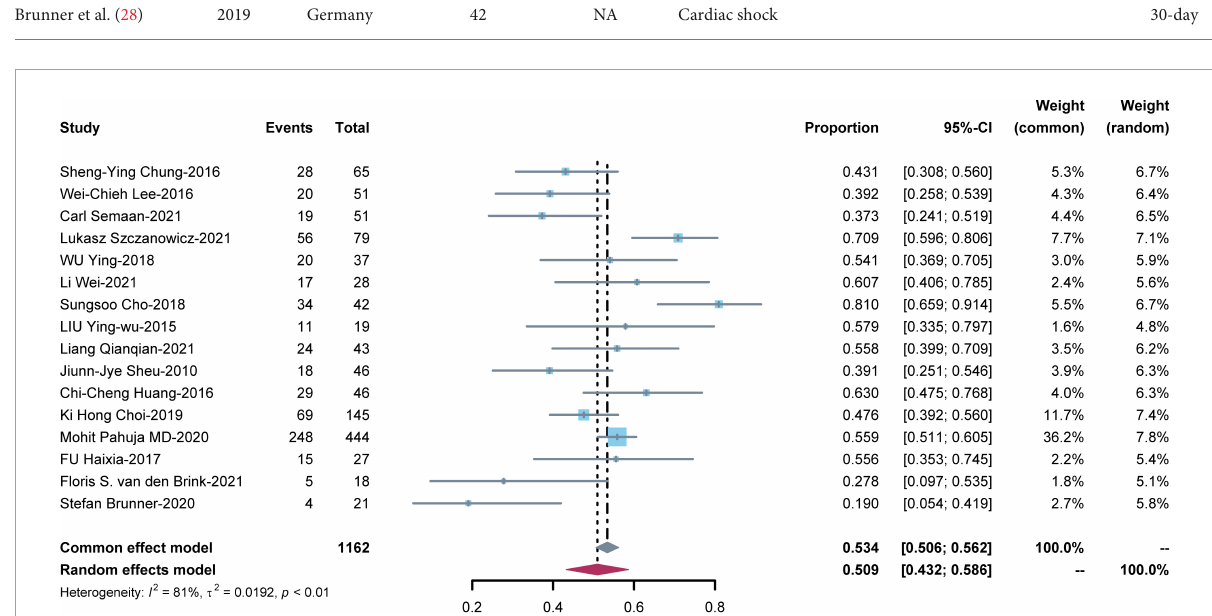
FIGURE2 Meta-analysis of short-term mortality for patients on venoarterial extracorporeal membrane oxygenation (V-A ECMO) for cardiogenic shock (CS) complicating ST-segment elevation myocardial infarction (STEMI).